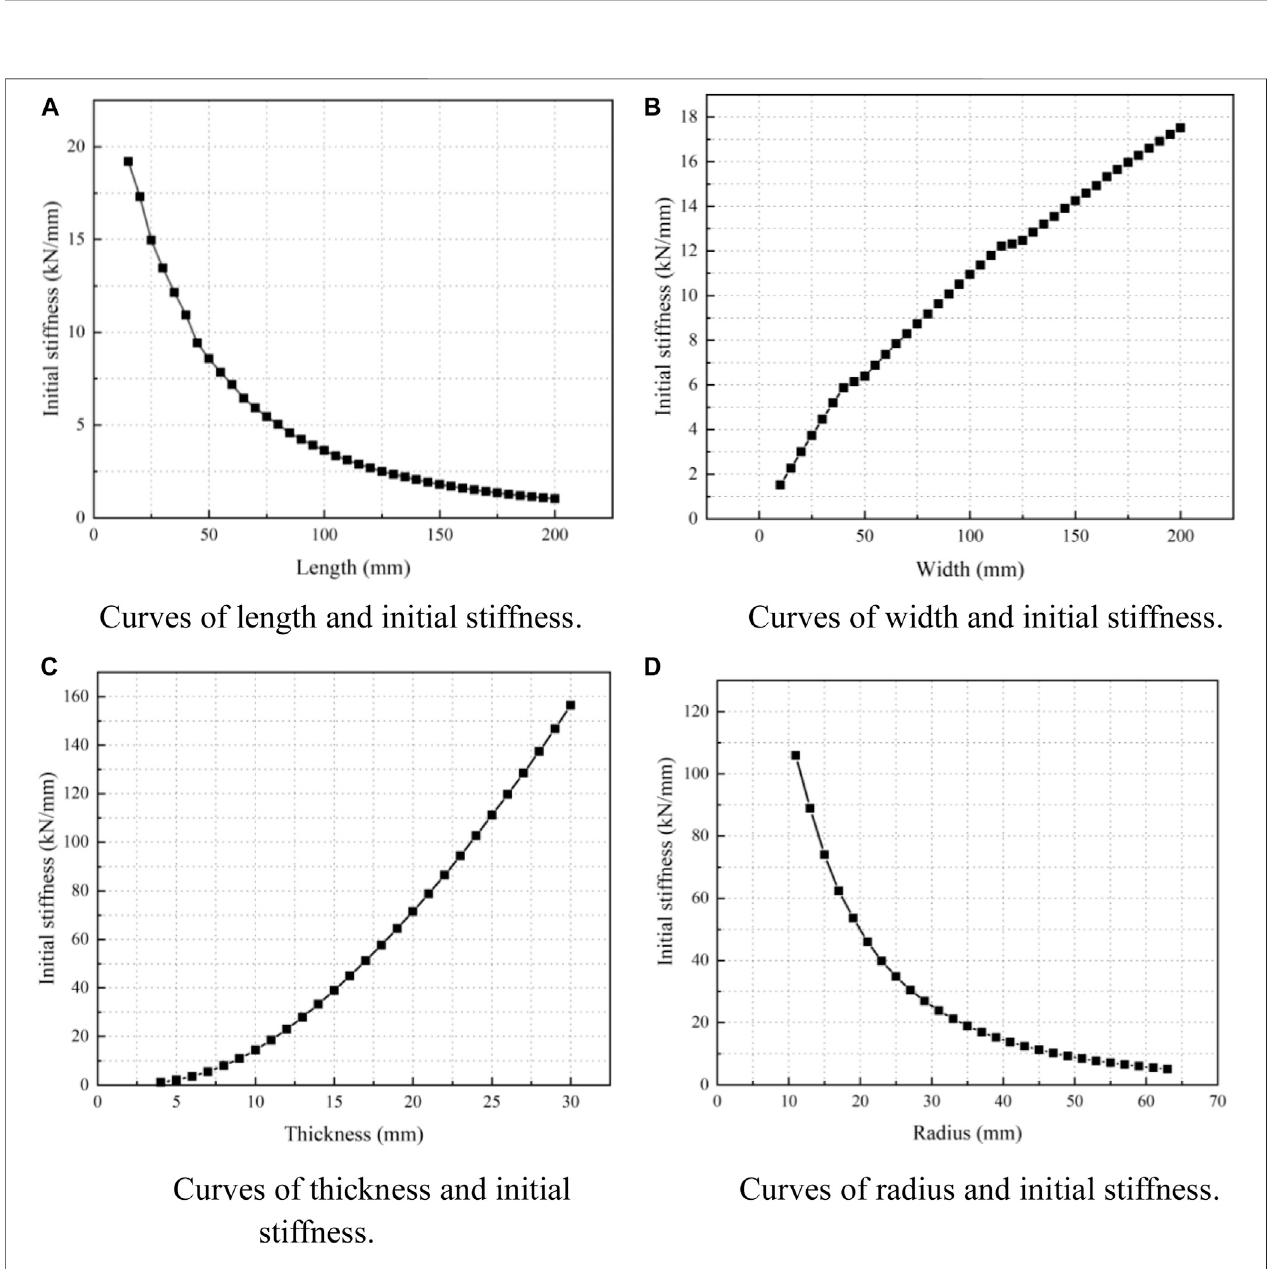
FIGURE 15 | Curves of parametric analysis. (A) Curves of length and initial stiffness. (B) Curves of width and initial stiffness. (C) Curves of thickness and initial stiffness. (D) Curves of radius and initial stiffness.